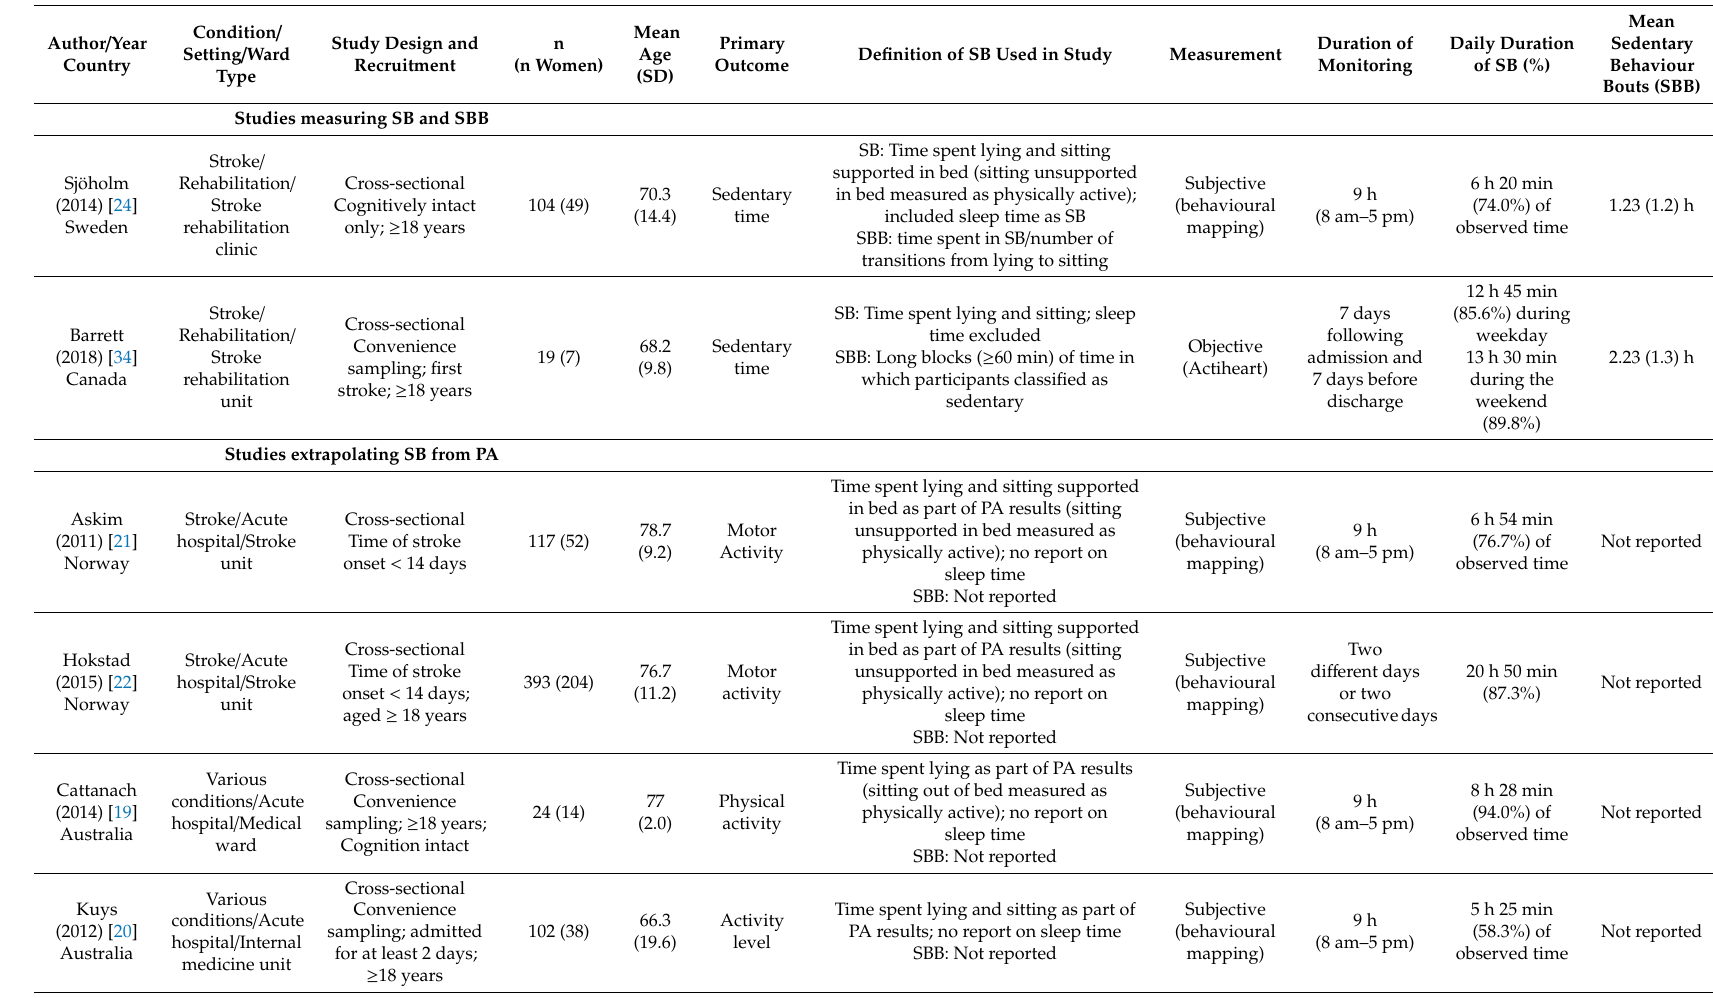
Table 1. Summary of included